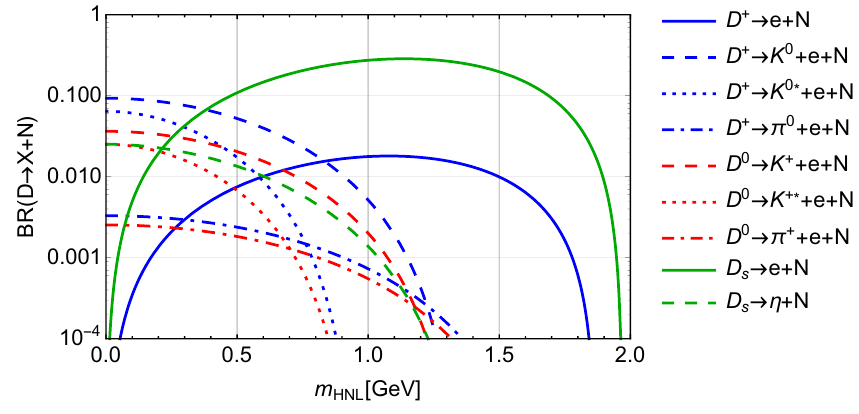
Figure 4 . Dominant branching ratios of HNL production from di(cid:11)erent charmed and beauty mesons. For charged mesons two-body leptonic decays are shown, while for the neutral mesons decays are necessarily semi-leptonic. For these plots we take U e = 1, U (cid:22) = U (cid:28) = 0.